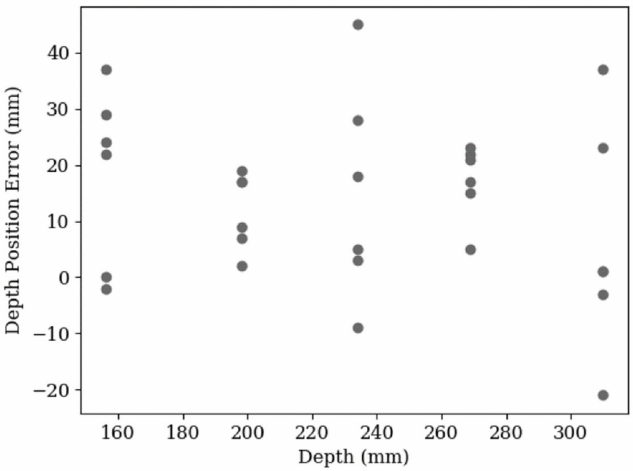
Figure 16. A scatter plot of the depth error in 30 leaf position estimations plotted against depth. The data shows a spread from − 21 mm to 45 mm. The RMS error is 20